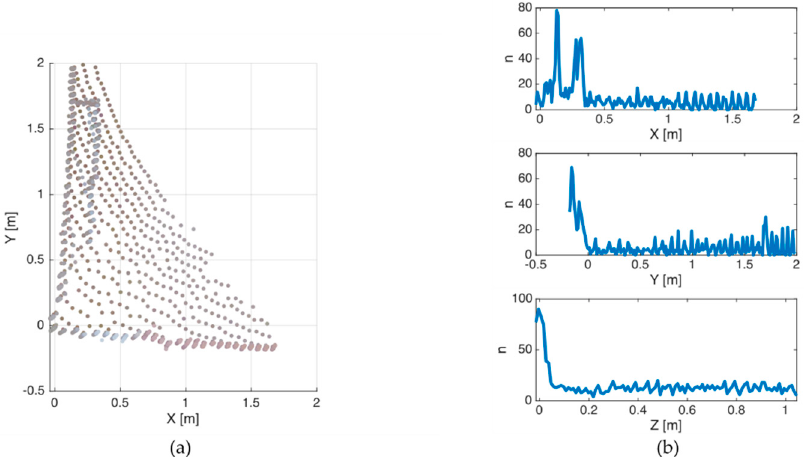
Figure 5. Output point cloud from the registration process: ( a ) X–Y top view; ( b ) Histograms of all coordinate axes.